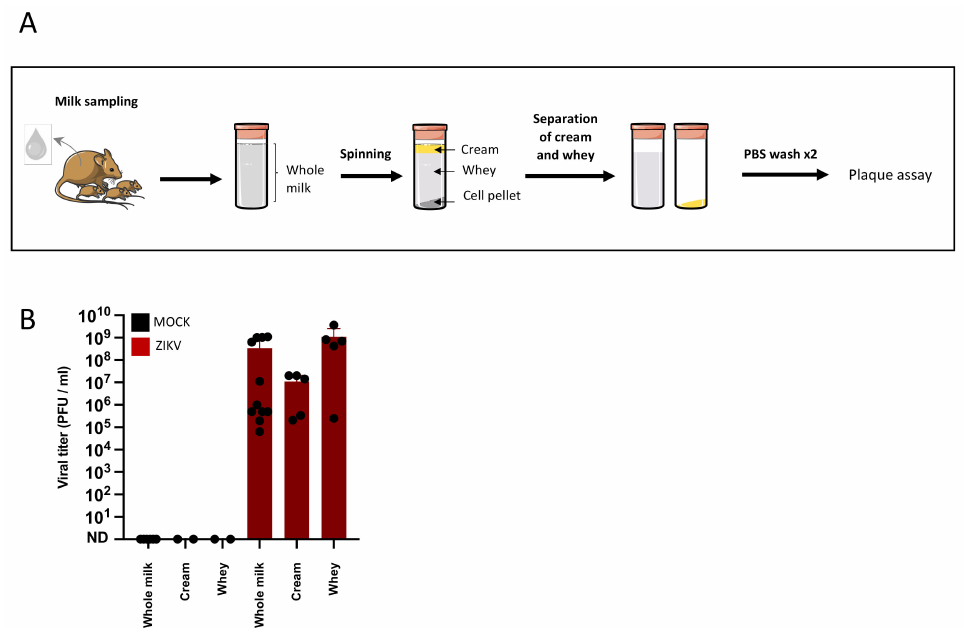
Figure 2. Infectious particles are excreted in murine breast milk. ( A ): Female dams were MOCK or ZIKV-infected with the Brazil/2016 strain as described in Figure 1. Breast milk samples were collected at 4 days post-infection and centrifuged to separate the cream fraction, the whey, and the cell pellet. The cream and whey fractions were isolated and further centrifuged twice with PBS to increase their purity. ( B ): The concentration of infectious viral particles in whole breast milk or breast milk fractions was determined by plaque assays (whole milk: n = 11; cream and whey: n = 5). 3.3. Murine Breast Milk Cells Are in Majority Mammary Epithelial